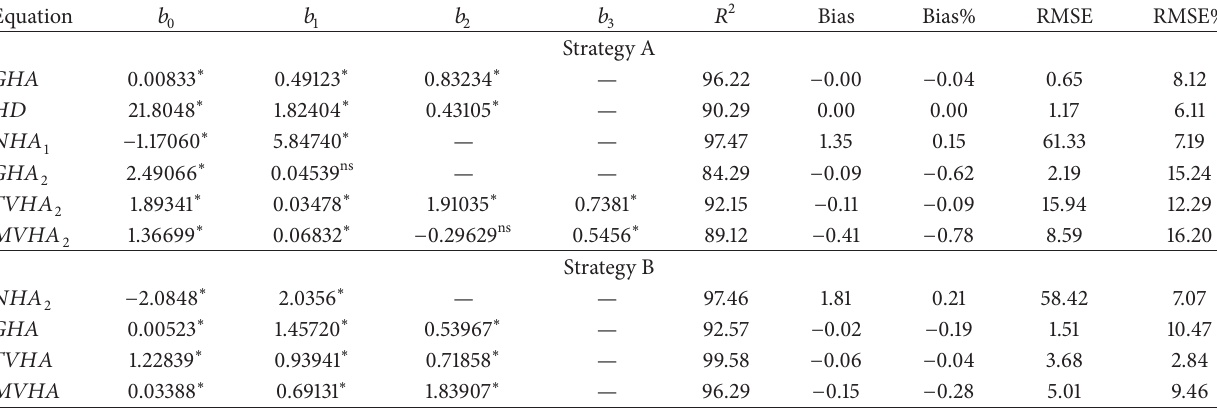
Table 2: Statistics obtained for the equations fitted for Strategies A and B.